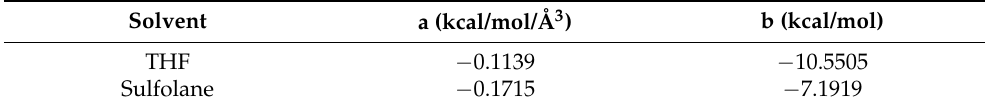
Table 2. Regression coefficients (a and b) used for the universal correction fitting of the solvation free energies obtained via the 3D-RISM-KH theory.